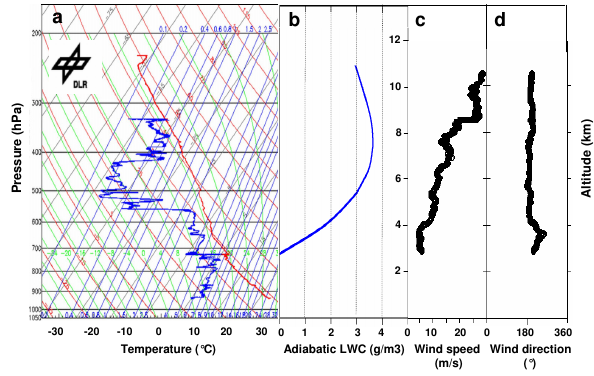
Fig. 2. Vertical profiles of (a) : temperature and Dew-point mea- sured by the Falcon; (b) : theoretical adiabatic liquid water con- tent (LWC); (c) and (d) : wind speed and direction components,